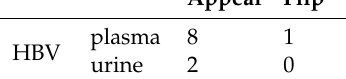
Figure 4. Metabolic perturbation networks for ( a , c ) HBV and ( b , d ) HCV in plasma ( a , b) (red node borders) and urine ( c , d ) (yellow node borders). Solid lines denote ‘appear’ type edges and zigzag lines ‘flip’ edges. The edge color reflects the slope of the correlation in HBV/HCV patients, with green denoting positive and red negative correlations. Table 2. Counts of the different edge types for the metabolic perturbation networks of each virus in each fluid. Appear